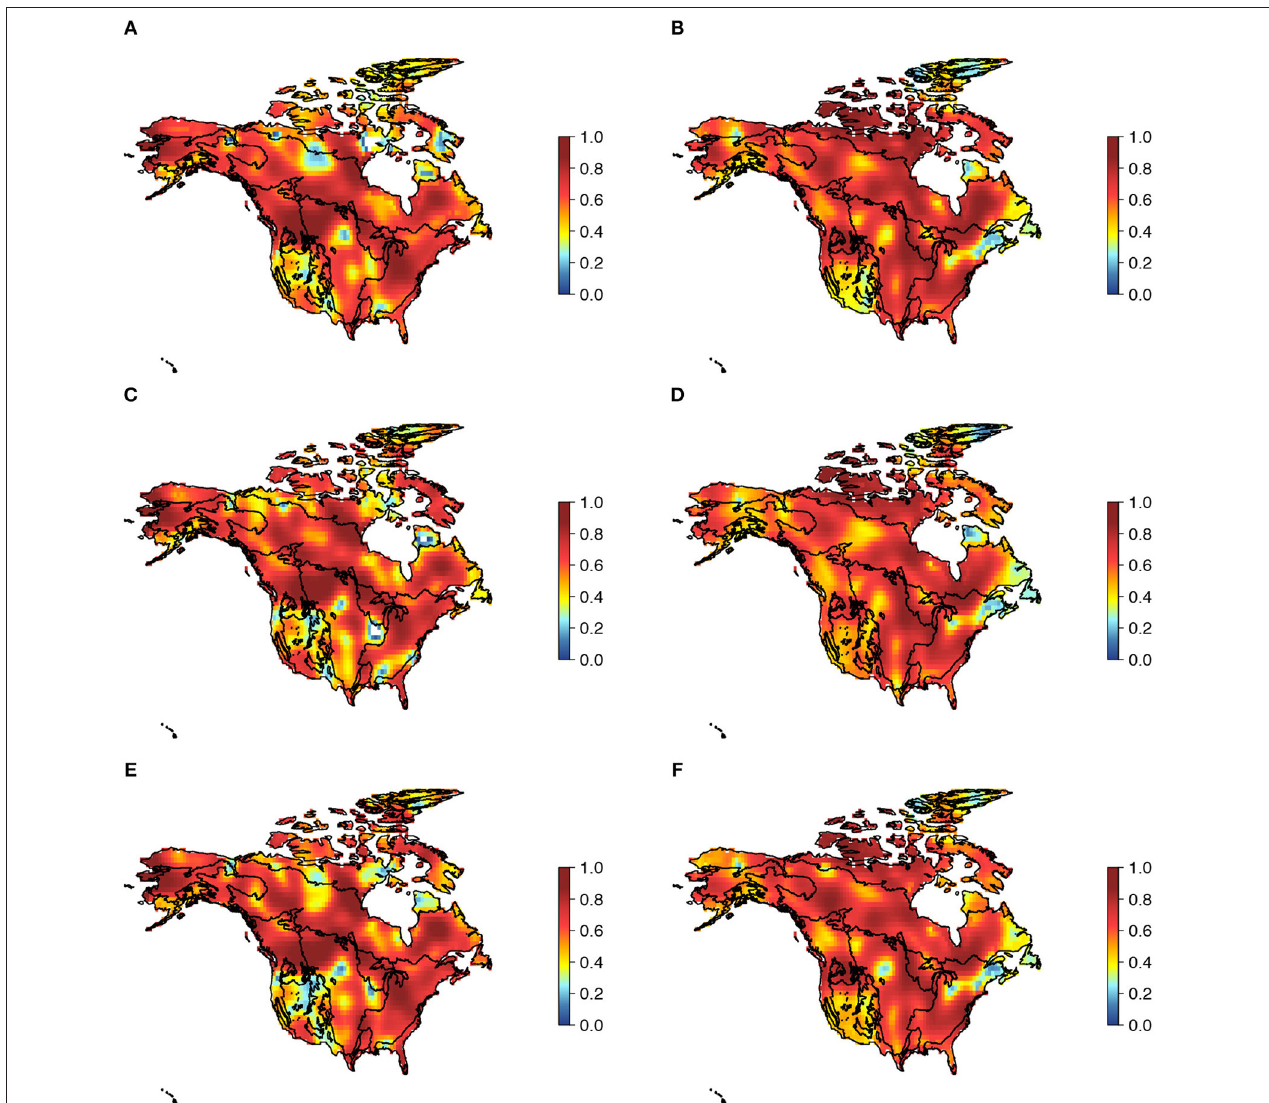
FIGURE 3 | Spatial pattern of the effect ( R 2 ) of environmental predictors on beta diversity components for the three dimensions of vascular plant diversity: (A,B) taxonomic β nes and β sim , (C,D) functional β nes and β sim , and (E,F) phylogenetic β nes and β sim